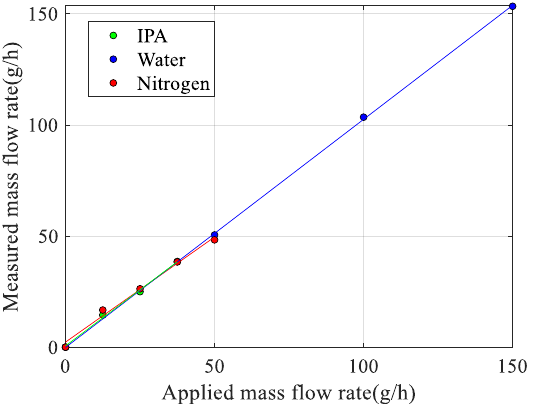
Figure 10. Measured mass flow rate as a function of applied mass flow rate for water, IPA, and nitrogen, using the theoretical response (14) to convert the measured response into the correspond- ing mass flow. mass flow.